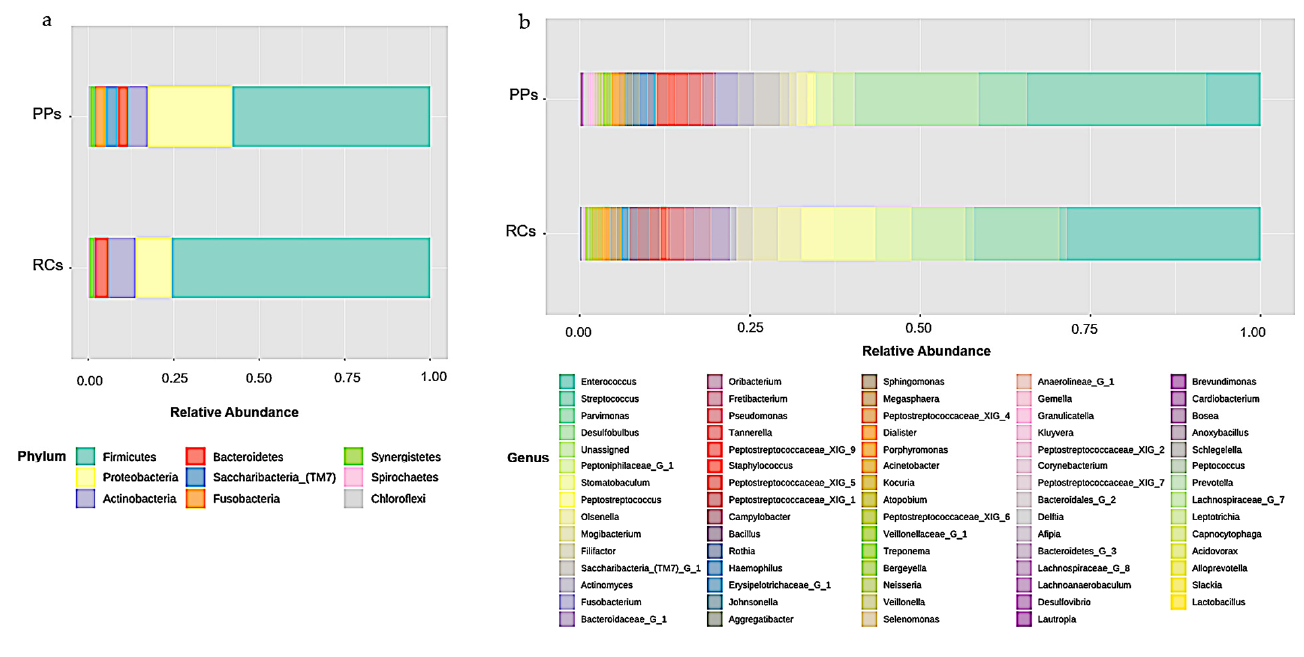
Figure 1. Relative abundance of ( a ) phyla ( b ) bacterial genera in root canals (RCs) and periodontal pockets (PPs). Gram-negative and gram-positive bacteria are virulent factors that are related to the degree of infection. A total of 589,936 (RCs) and 278,145 (PPs) reads were annotated for gram-positive bacteria, while 81,358 (RCs) and 269,165 (PPs) reads were annotated for gram-negative bacteria (Figure 2). Picture 2 also shows other phenotypic characteristics of the taxa present in the RCs and